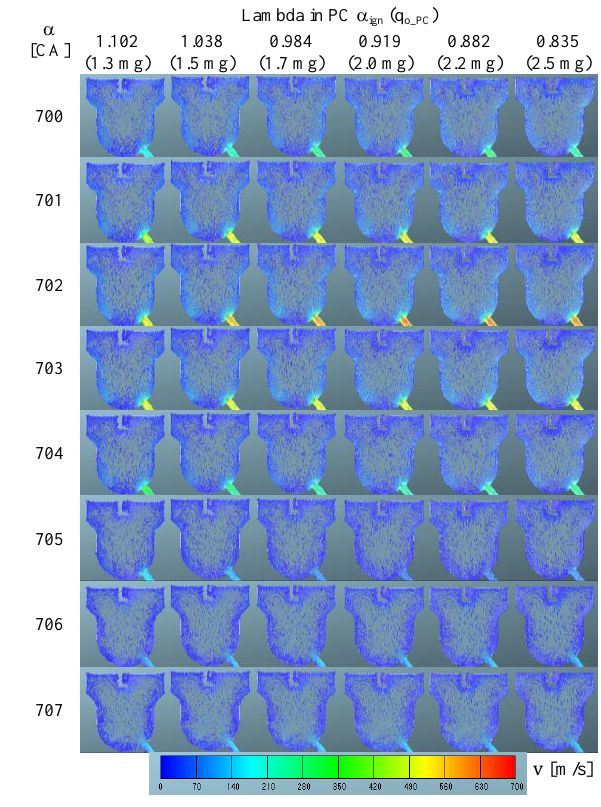
Fig. 7. Combustion pressure characteristic in the prechamber